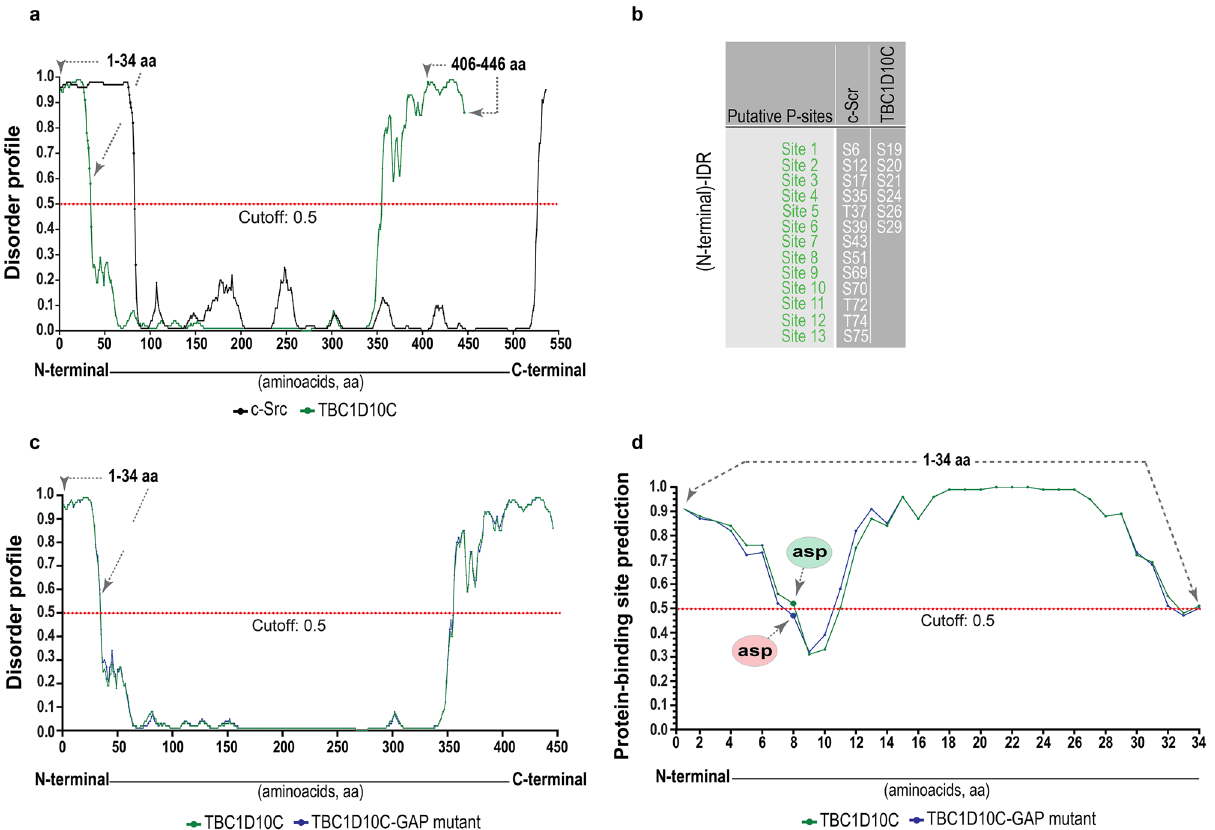
Figure 5. Prediction of intrinsically disordered regions (IDRs) and phosphorylation sites in TBC1D10C. ( a ) Intrinsic disorder profiles of the amino acid composition of human TBC1D10C (green dotted line) and human Src (black dotted line) are plotted. Regions of amino acids are considered disordered above the confidence score (cutoff: 0.5; gray dashed line). A (N-terminal)-IDR in TBC1D10C similar to the (N-terminal)-IDR in Src as well as a (C-terminal)-IDR in TBC1D10C that includes the calcineurin interacting region (406–446 aa); ( b ) 13 and 6 putative phosphorylation sites are shown for the (N-terminal)-IDR in Src and TBC1D10C, respectively; ( c ) intrinsic disorder profile of the amino acid composition of human TBC1D10C (green dotted line) and human TBC1D10C GAP mutant (blue dotted line) are plotted; ( d ) prediction of protein-binding sites in the (N-terminal)-IDR of TBC1D10C (green dotted line) and TBC1D10C GAP mutant (blue dotted line) (residue 8, asp, aspartic acid is significantly different predicted as a protein-binding site as a consequence of R141K mutation in